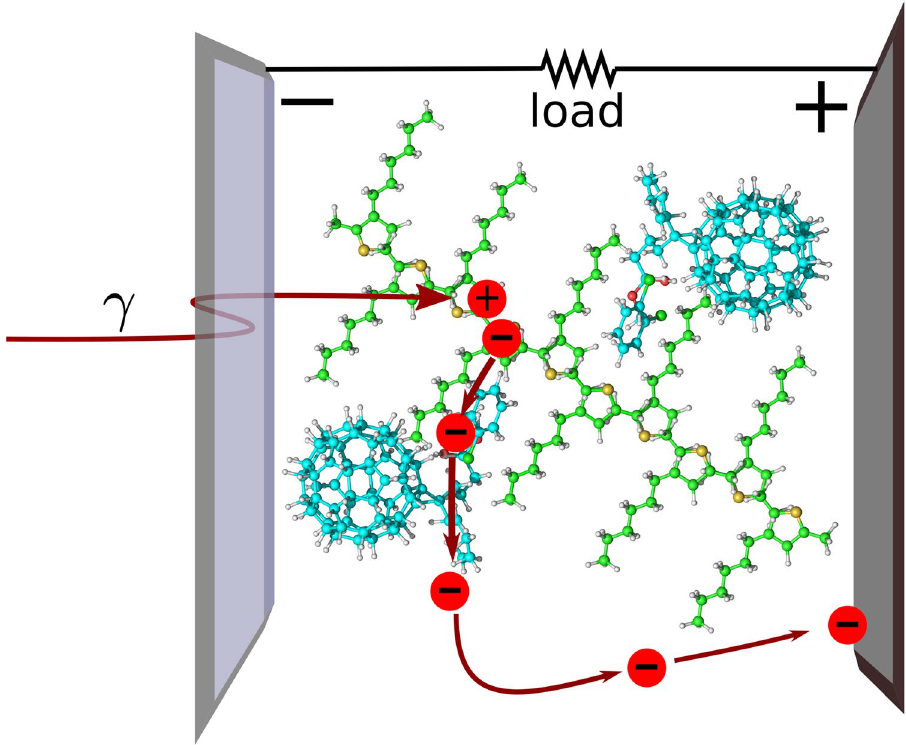
Figure 1. Simplified portrayal of a bulk nanostructure heterojunction P3HT(Poly(3-hexylthiophene-2,5-diyl)): PCBM solar cell, where incoming photons induce electronic transitions to a higher state of a π orbital in a monomer of –in this case– P3HT. Thus a Coulomb bound electron-hole pair is formed, from which the electron rapidly migrates to the interface of the polymer with the acceptor material (fullerene derivative PCBM here), whereupon charge separation takes place and a net photocurrent is created, leading ultimately to electricity